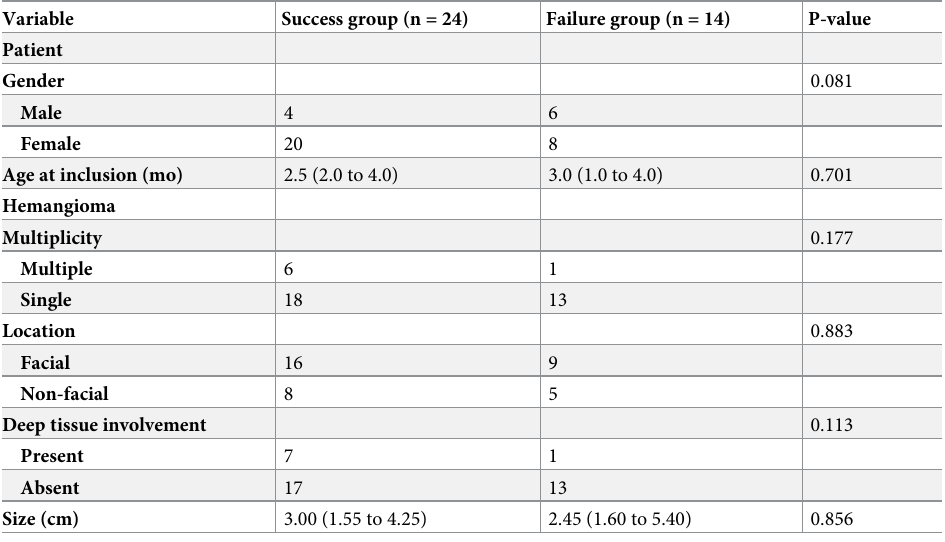
Table 2. Clinical characteristics according to successful treatment. Variable Success group (n = 24) Failure group (n = 14)